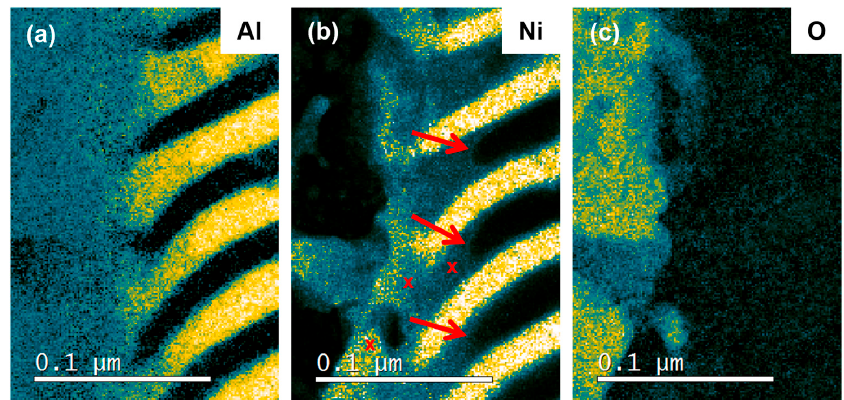
Figure 6. Normalized EELS intensity mapping of the elements ( a ) Al, ( b ) Ni, and ( c ) O in the 100fs_1kHz sample. A significant amount of Ni can be found in the first 50 nm of the Al layers. The oxide region contains mainly aluminum. Arrows in ( b ) indicate how far the Ni signal was observed in the Al layers. Red crosses indicate the positions of EELS composition measurements.